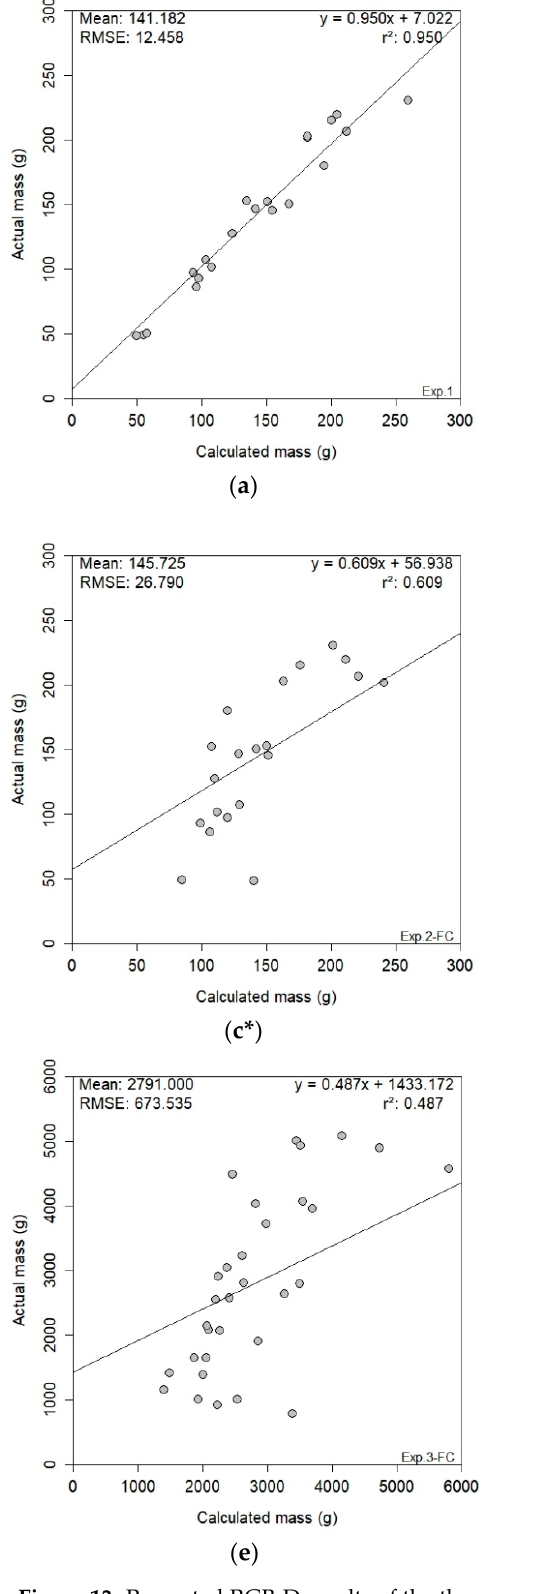
Figure 13. Presented RGB-D results of the three experiments; experiment one ( a ), experiment two FC (n = 21) ( b ), experiment two FC* (n = 20) ( c ), experiment two LR ( d ) and experiment three FC ( e ) & LR ( f ). {Key: Exp. = experiment; FC = full canopy; LR = leaf removal; *statistical outlier removed, resulting in 20 bunches}.